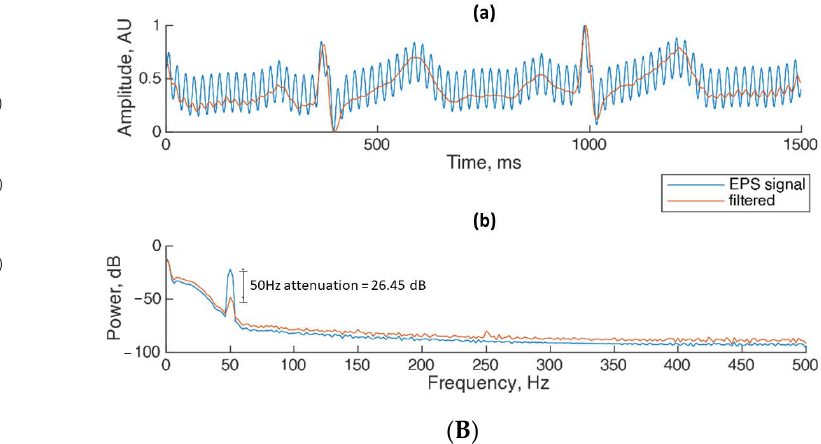
Figure 3. ( A ) The tissue phantom with an embedded electric field sensor. The stack consists of (a) foam block and weight, (b) insulating constraint layer, (c) electric field sensor, (d) agar phantom, (e) ground loop, (f) electric field source emitter. ( B ) Experimental results when applying the proposed denoising method on ECG bio-signals. (a) Human ECG signal collected using the sensors before (EPS signal) and after the denoising method is applied (filtered); (b) PSD measurements before and after the denoising method is applied.